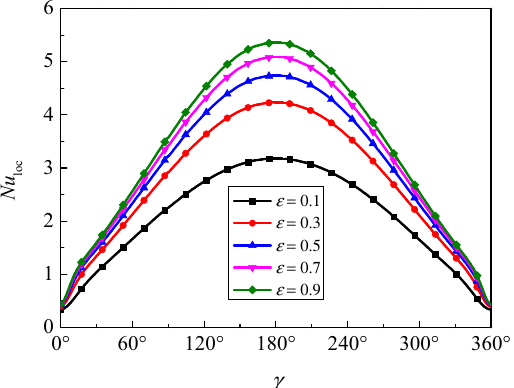
Figure 17. Average Nusselt number ( Nu avg ) of the inner wall for different porosity ( ε ) and Darcy numbers ( Da ) at Ra = 5 × 10 4 , ϕ = 0.05, d sp = 50 nm, and RR = 2.